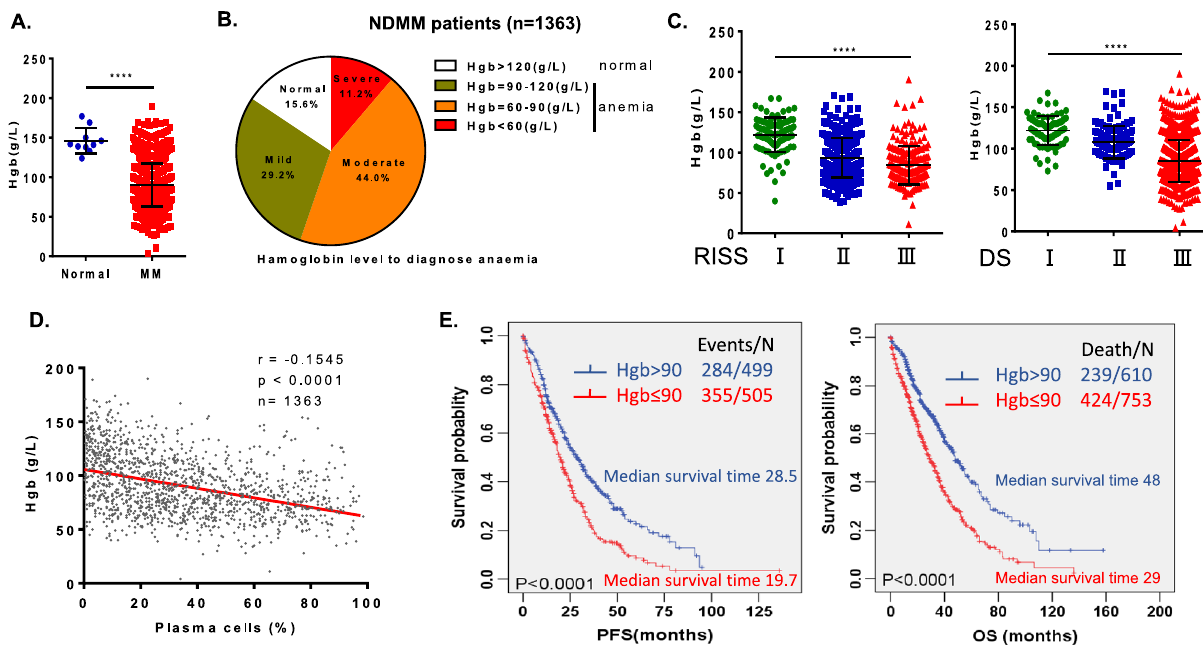
Figure 1. Anaemia is an important symptom of myeloma and correlates with worse outcomes in myeloma patients. ( A ) The clinical data of a large cohort of myeloma patients showed the levels of haemoglobin in normal donors (n = 10) and NDMM patients (n = 1363). ( B ) The clinical analysis showed that 84.4% (1150/1363) of NDMM patients had anaemia at diagnosis, and 55.2% (753/1363) of patients had moderate (90–120 g/L) or severe (60–90 g/L) anaemia. ( C ) The decrease in haemoglobin in NDMM patients was positively correlated with the disease stage. R-ISS stage (left) or DS stage (right). ( D ) The levels of haemoglobin in NDMM patients were negatively correlated with myeloma cell infiltration in the bone marrow (r = − 0.1545, p < 0.0001, n = 1363). ( E ) Kaplan–Meier analysis showed shorter survival of myeloma patients with decreased haemoglobin